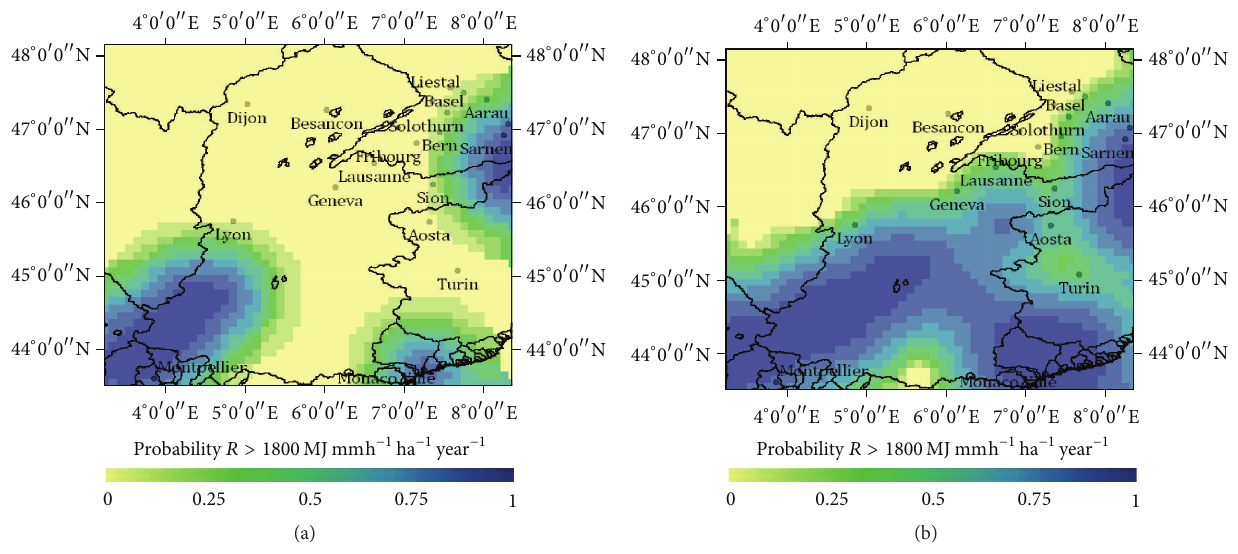
Figure 5: Indicator Kriging maps with probability that rainfall erosivity ( R ) exceeds 1800MJmmh −1 ha −1 y −1 , for the periods 1961–1990 (a) and 1991–2010 (b).